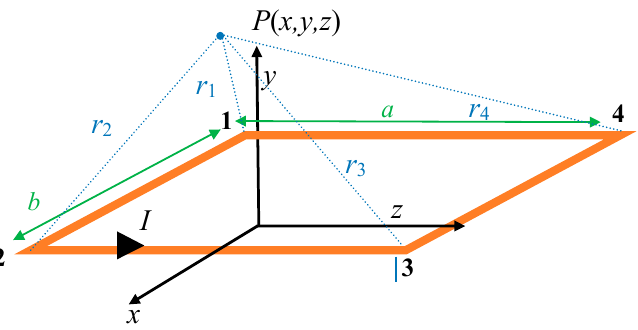
Figure 4. Magnetic flux density produced by a rectangular coil.